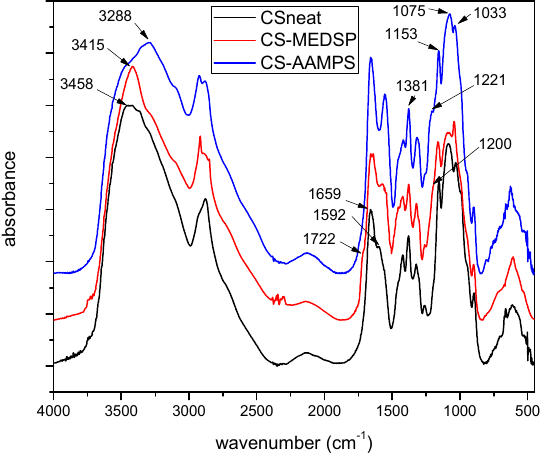
Figure 1. FT-IR spectra of neat CS and its derivatives with AAMPS and MEDSP.